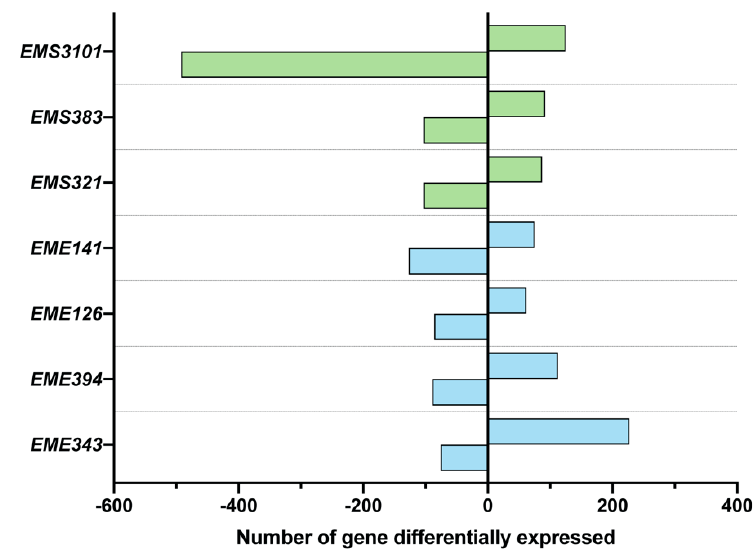
Figure 5. The number of differentially expressed genes is specific to the strain. Following bacterial challenge for 6 h, RNA from the BEAS-2B cells culture was analyzed by genome-wide expression analysis, using Agilent Whole Human 4x44K microarrays. Gene expression changes were expressed as fold of bacteria-treated compared to untreated control (culture medium only). Genes were considered significantly differentially expressed when (i) a t-test p- value of less than 0.05 and (ii) a cutoff in transcript abundance of least 1.5-fold change were observed. Data are expressed as the number of gene differentially expressed. Strains are identified as follows: EMS , Streptococcus strains; EME , Enterococcus strains.